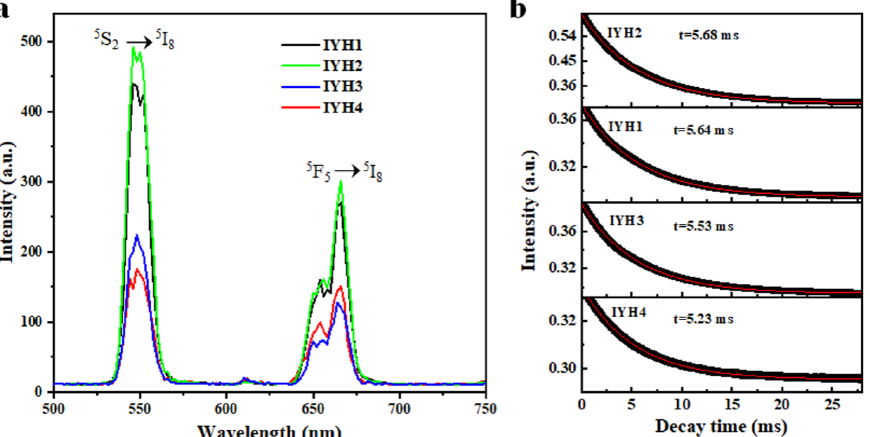
Figure 2. Upconversion emission spectra ( a ) and 550 nm fluorescence decay curves ( b ) of In:Yb:Ho:LiNbO 3 crystals under 980 nm